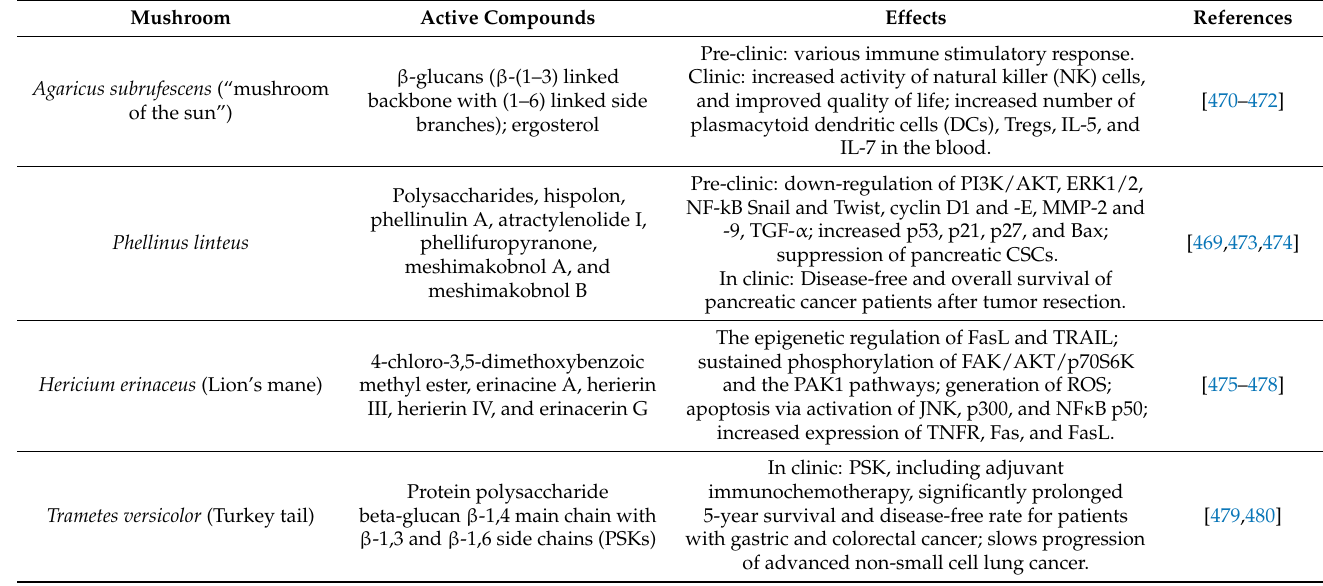
Table 7. Others mushrooms and their compounds with strong anti-neoplastic